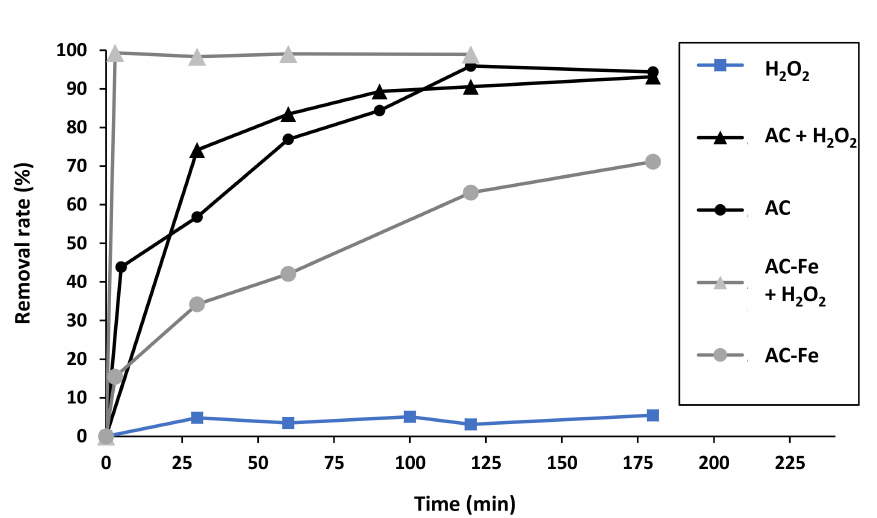
Figure 6. TBO removal upon treatment with AC and AC-Fe in the presence and absence of H 2 O 2 . Experimental conditions: pH = 3.5, [TBO] 0 = 50 mg/L, [H 2 O 2 ] = 4 mmol/L, [AC-Fe] = 1.2 g/L, reaction temperature = 20 ◦ C.